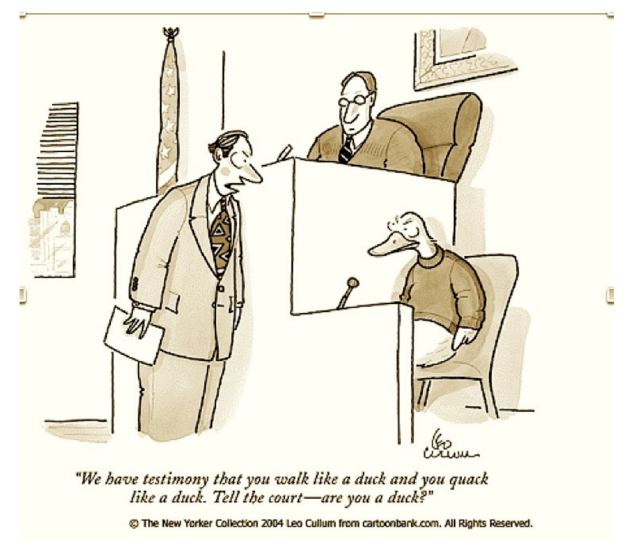
Figure 1. The Duck Principle: “But when I see a bird that quacks like a duck, walks like a duck, has feathers and webbed feet and associates with ducks, I’m certainly going to assume that he IS a duck.”—Emil Mazey Secretary-Treasurer UAW Labor leader